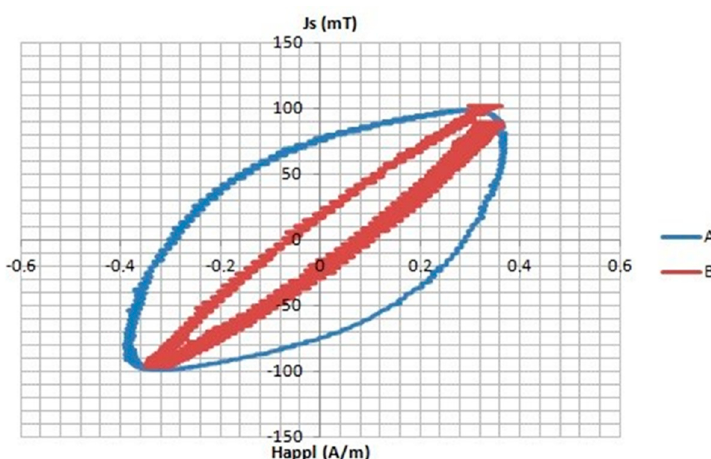
Figure 2. Hysteresis loop at low-applied magnetic field of the two nanocrystalline magnetic cores.